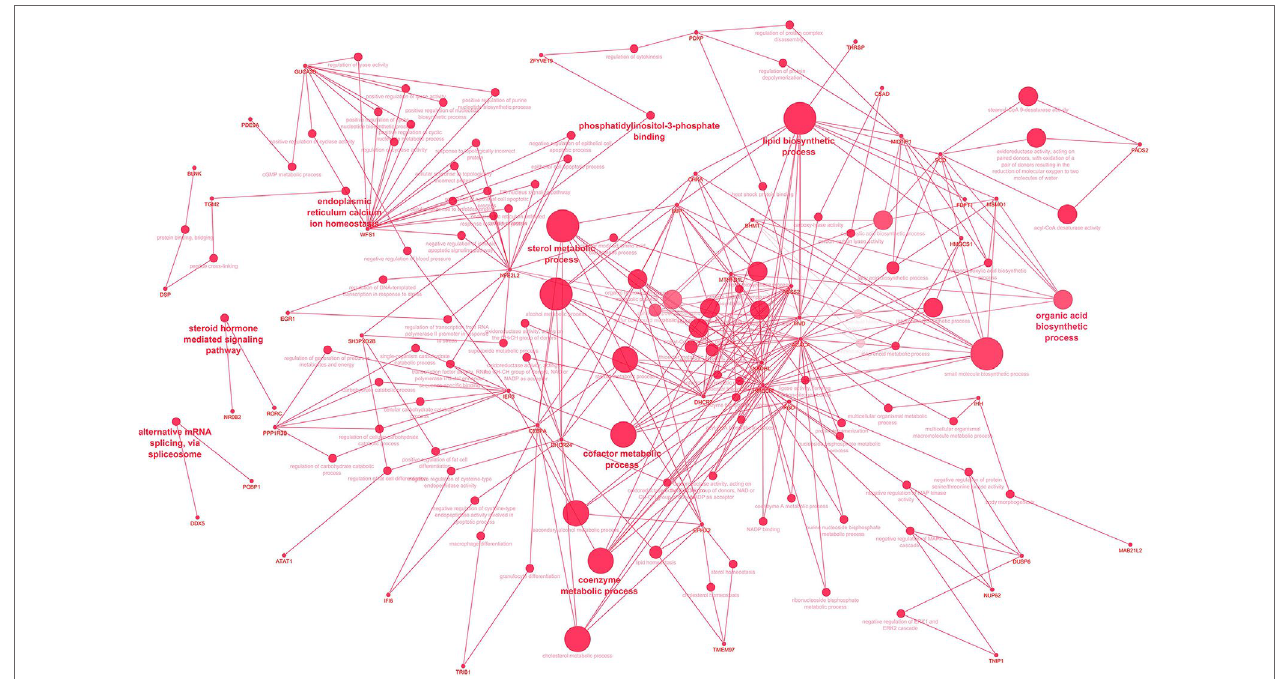
FiGURE 5 | The biological role of up- (green) and downregulated (red) genes in ALF animals visualized with ClueGO in the liver. The size of the nodes reflects the statistical significance of the term.